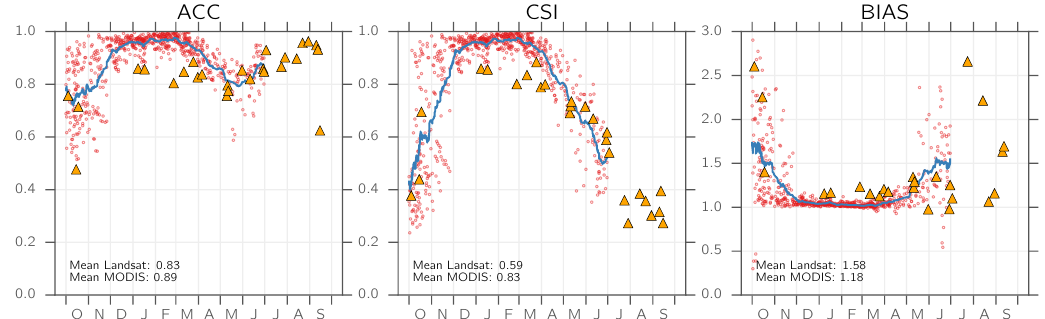
Figure 8. ACC, CSI, and BIAS for all selected Landsat (triangles) and MODIS (red circles; blue line is the 30-day running mean) scenes, sorted by calendar